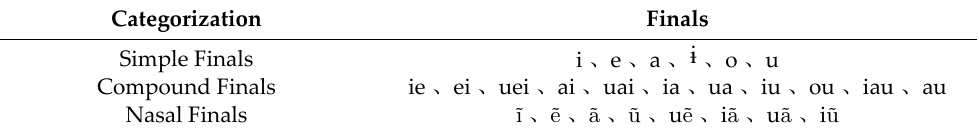
Table 3. Finals of Tujia language.